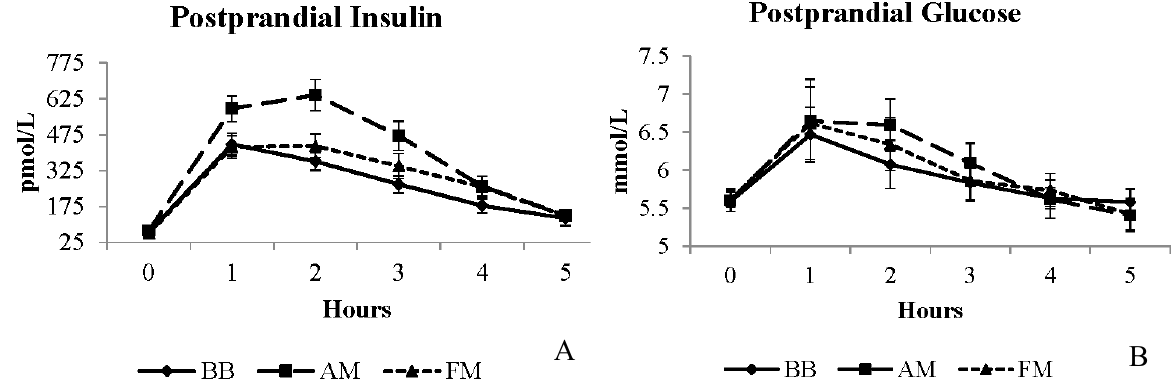
Figure 2. Postprandial insulin ( A ) and glucose ( B ) responses to moderate-fat breakfast with BB, AM, or FM. BB, black bean meal; FM, fiber matched meal; AM, antioxidant matched meal.